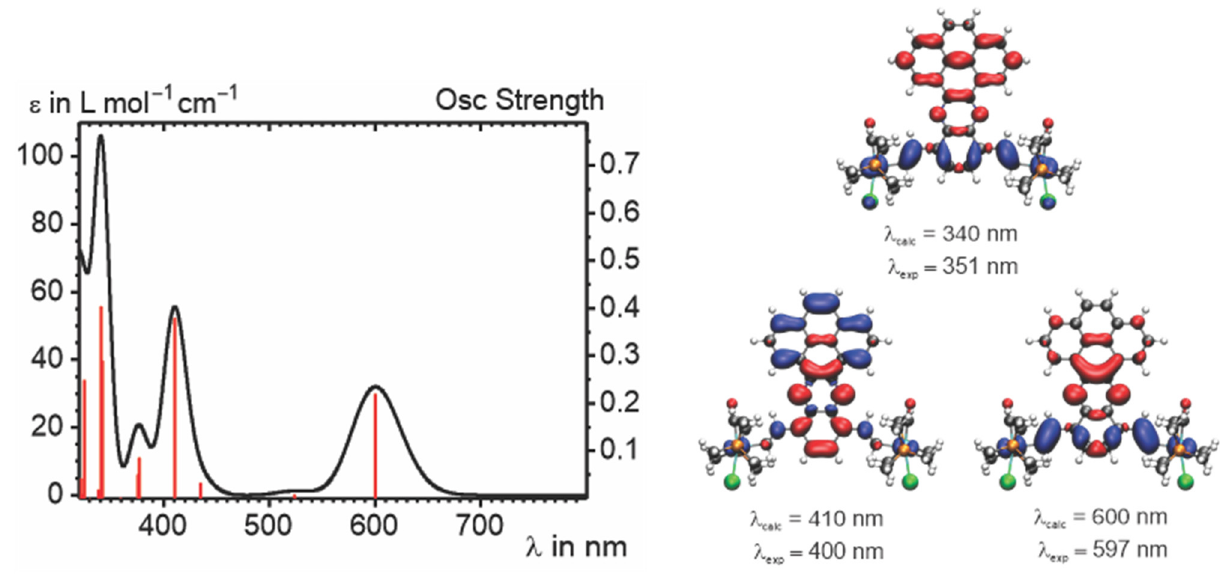
Figure 7. Left: Calculated UV–vis–NIR spectrum of model complex Me Ru 2 -3 obtained from TD-DFT calculations. Right: Electron density difference maps (EDDMs) for the three main electronic transitions in the visible/near UV. The red colour marks an increase and blue colour marks a decrease of electron density during the corresponding electronic transition.